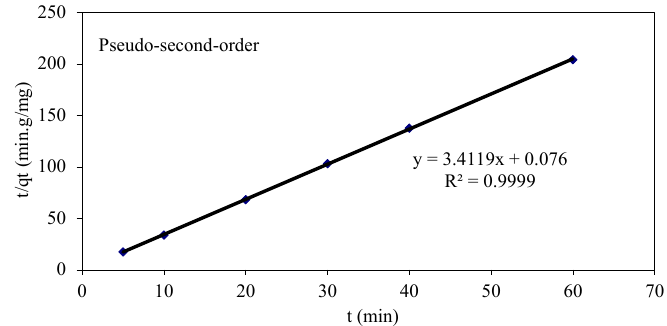
Fig. 10. Sorption kinetics fitted by pseudo-second order of Cd 2+ onto the adsorbent in solution.